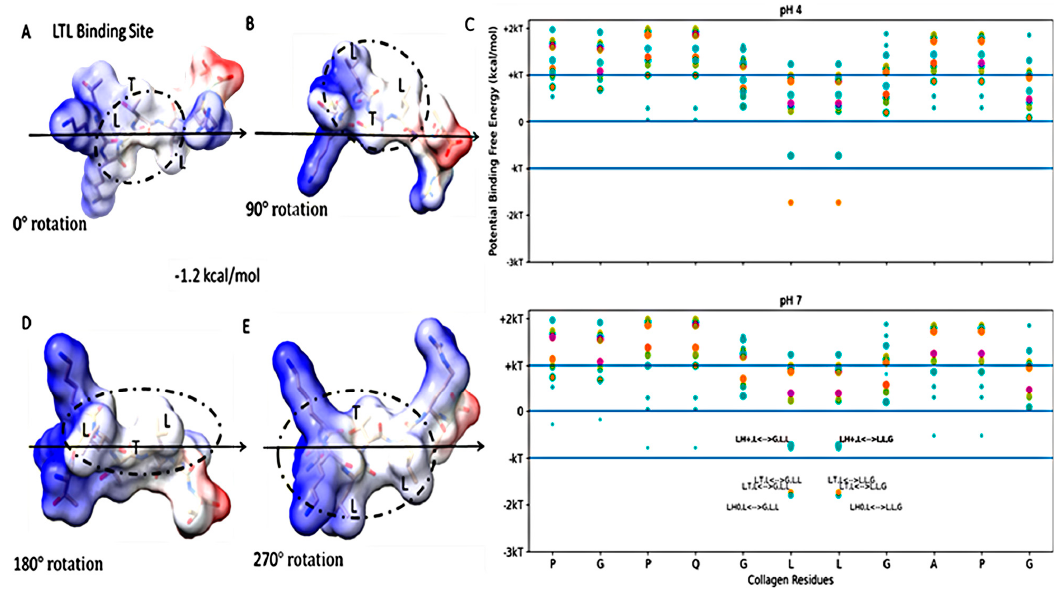
Figure 5. Free energy of binding estimates for sets of three adjacent residues for the high-stability collagen-binding peptide (TKKLTLRT) on human collagen type I alpha chain 2 (COL1A2) residues 861–871. The binding site (LTL) reference view is in ( A ), with views of 90° rotations along the indi- cated axis in ( B , D , E ). Each circle represents a potential three-amino-acid binding site between a peptide and collagen. Positive binding sites are energetically unfavorable, while negative binding sites are favorable. Binding sites significantly below − kT are likely to be stable. The potential binding free energy was calculated from the Wimley–White hydropathy scale values for the amino acids within the binding site. In ( C ), the predicted binding sites for the TKKLTLRT peptide (orange) was shown to include a binding site (LTL of peptide to GLL of collagen or LLG of collagen) at pH 4 which is missing from TKKTLRT (magenta). The LRR-10 cyan labeled binding sites are the same as in Figure 3. This binding site is the lowest free energy binding site among LRR-10 binding sites (cyan) and TKKTLRT binding sites at pH 4. This labeled TKKLTLRT binding site of LTL at pH 7 is about the same free energy as the lowest energy binding site of LRR-10 shown in Figure 4.